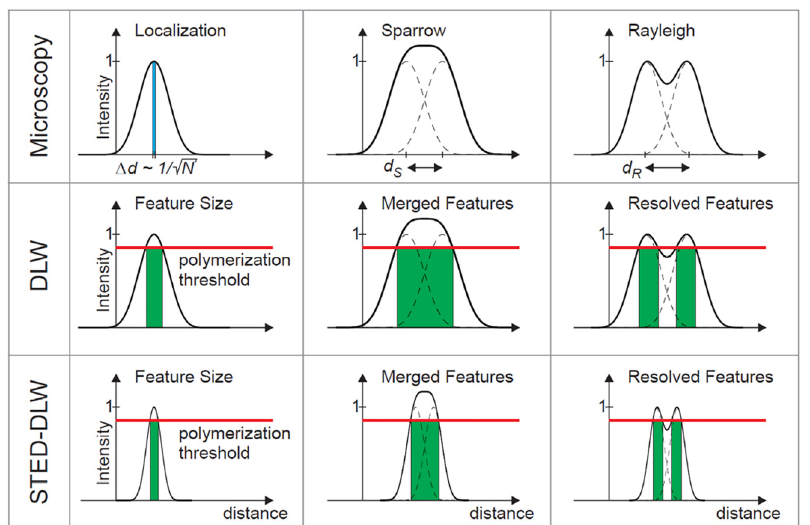
Figure 7: A graphical representation of how two-colour lithography works, and com- parison with STED